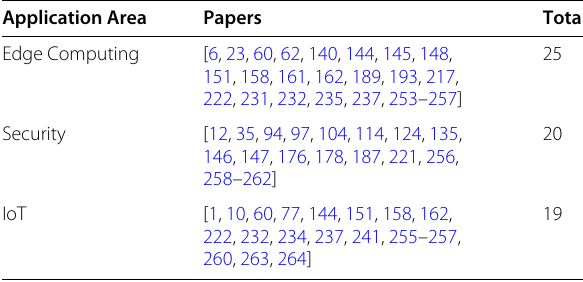
Table 8 Top three serverless application